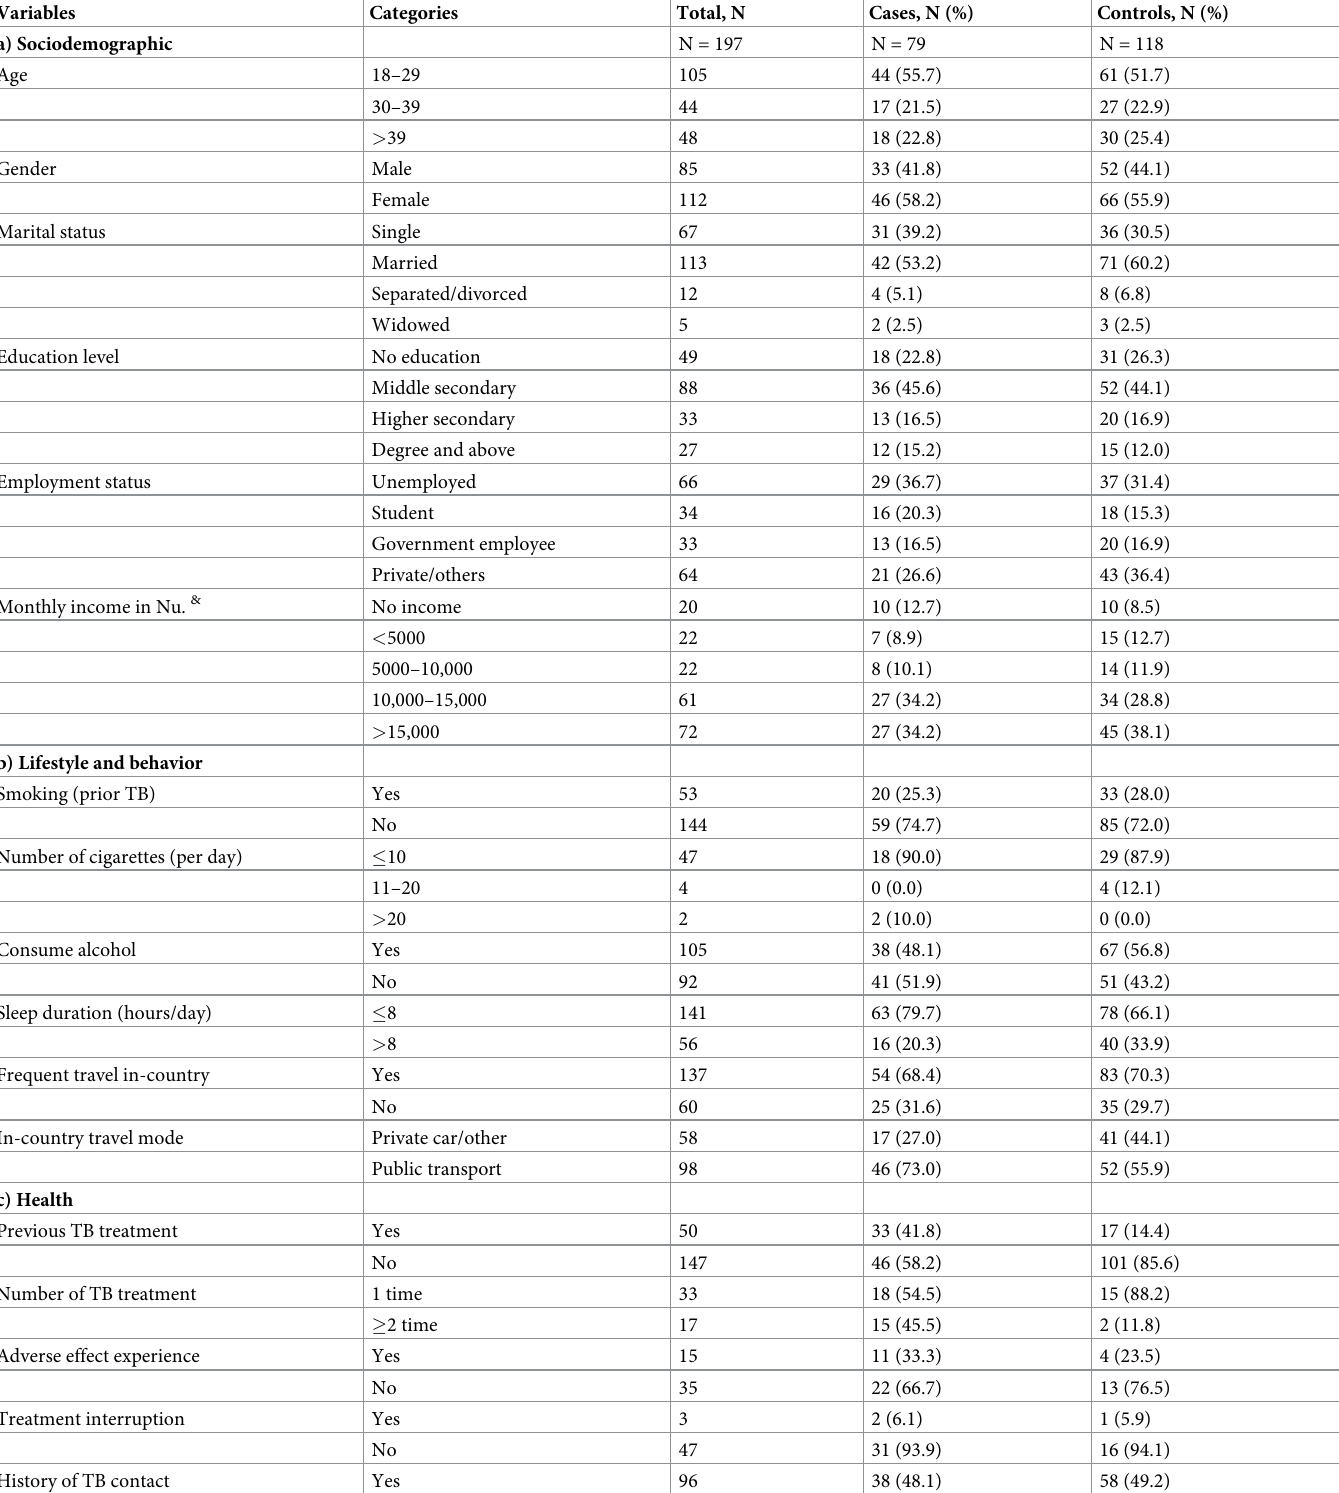
Table 1. Distribution of cases (MDR-TB) and controls (non MDR-TB) by the risk